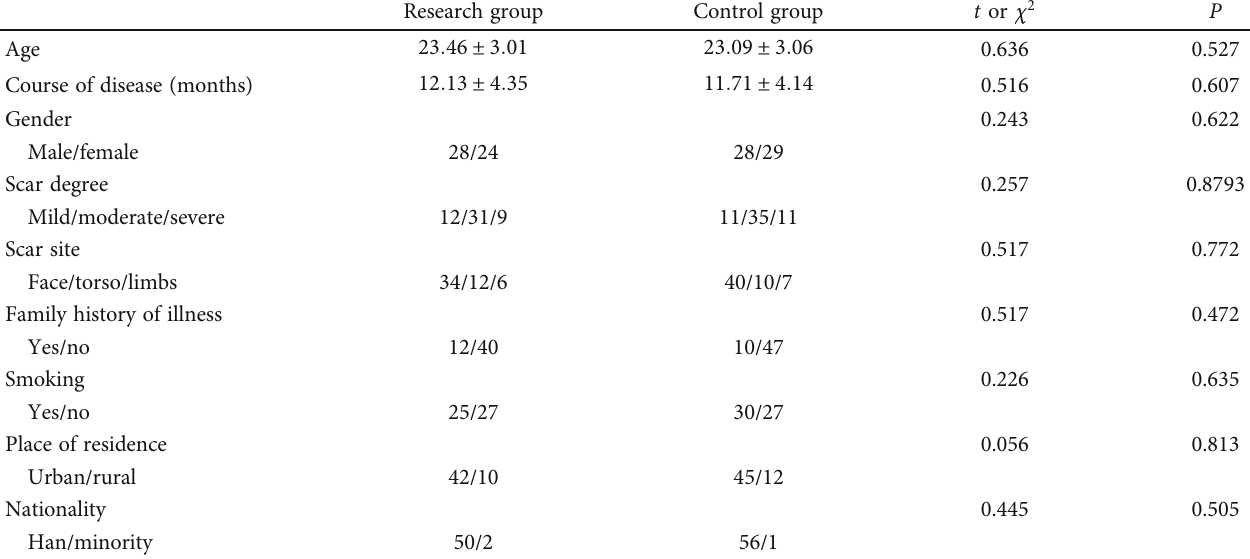
Table 1: Comparison of clinical baseline data.